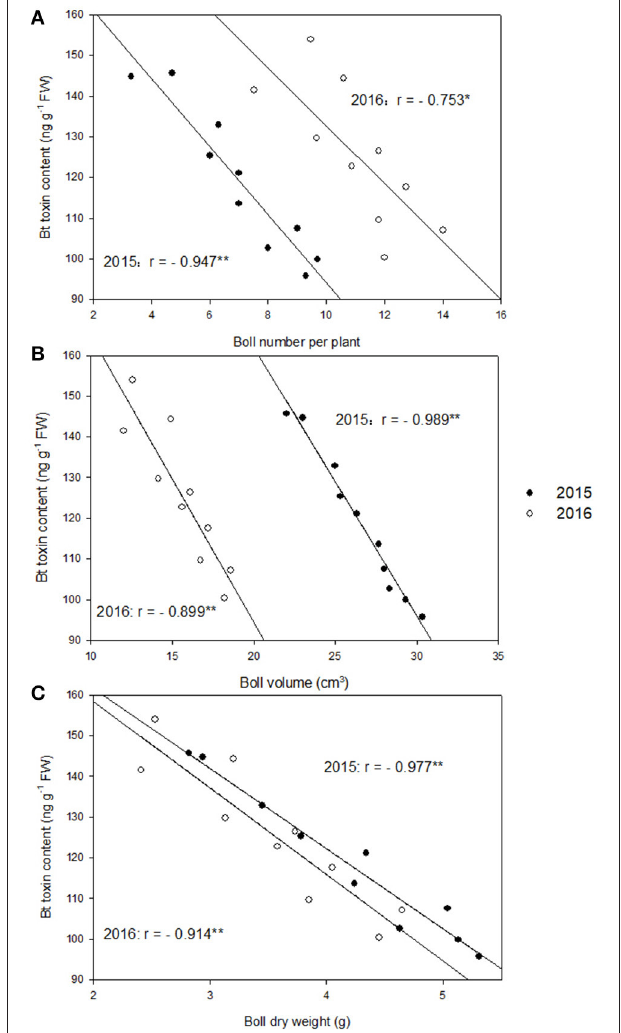
FIGURE 1 | Correlations between boll shell Bt toxin content and boll number per plant (A) , boll shell Bt toxin content and boll volume (B) , and boll shell Bt toxin content and boll dry weight (C) at 20 DAF (days after flowering) in 2015 and 2016. * and ** represent the significant level of 0.05 and 0.01,